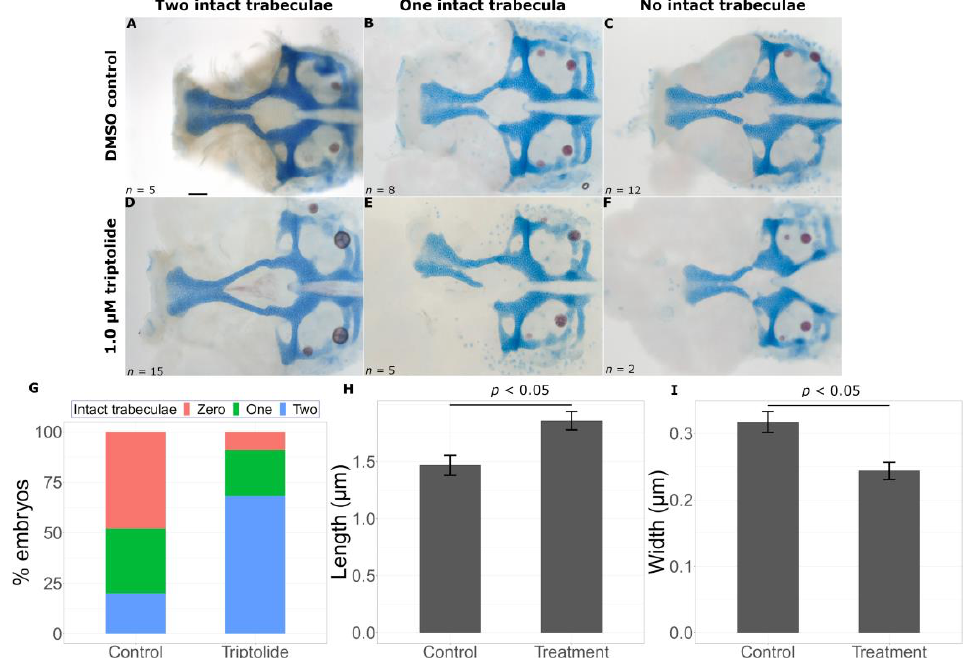
Figure 7. Triptolide suppresses the gata3 mutant phenotype. Representative flat mounts show breaks in the trabeculae with DMSO treatment ( A – C ) and chemical treatment ( D – F ). Triptolide treatment leads to a statistically significant increase in intact trabeculae count (( G ), p < 0.05), an increase in trabeculae length (( H ), p < 0.05) and a decrease in trabeculae width (( I ), p < 0.05). Error bars represent SEM. Scale bar = 0.5 μ m.